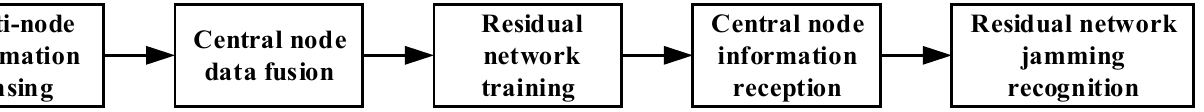
Figure 3. Multi-node cooperative jamming recognition process.